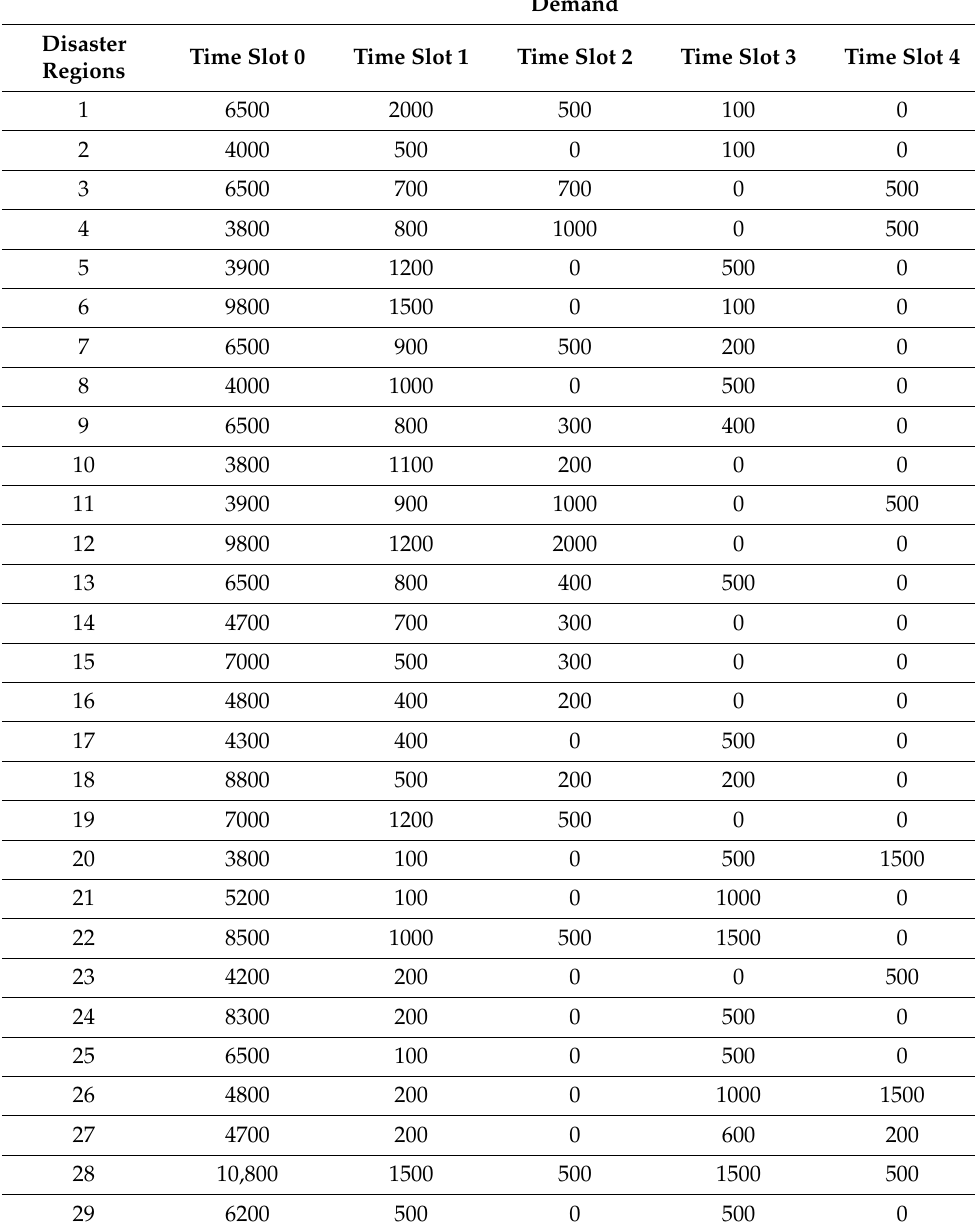
Table 4. Demand status of disaster regions at different